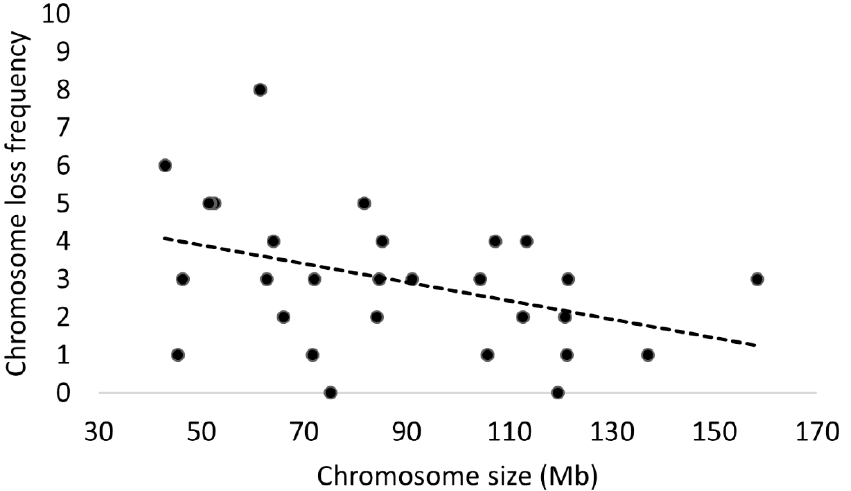
Figure 6. Frequency of chromosome loss in hypotriploidy. A significant trend was present, sug- gesting smaller chromosomes are more often lost in hypotriploidy ( p = 0.016), even though the goodness of fit of this model was only modest (R 2 =